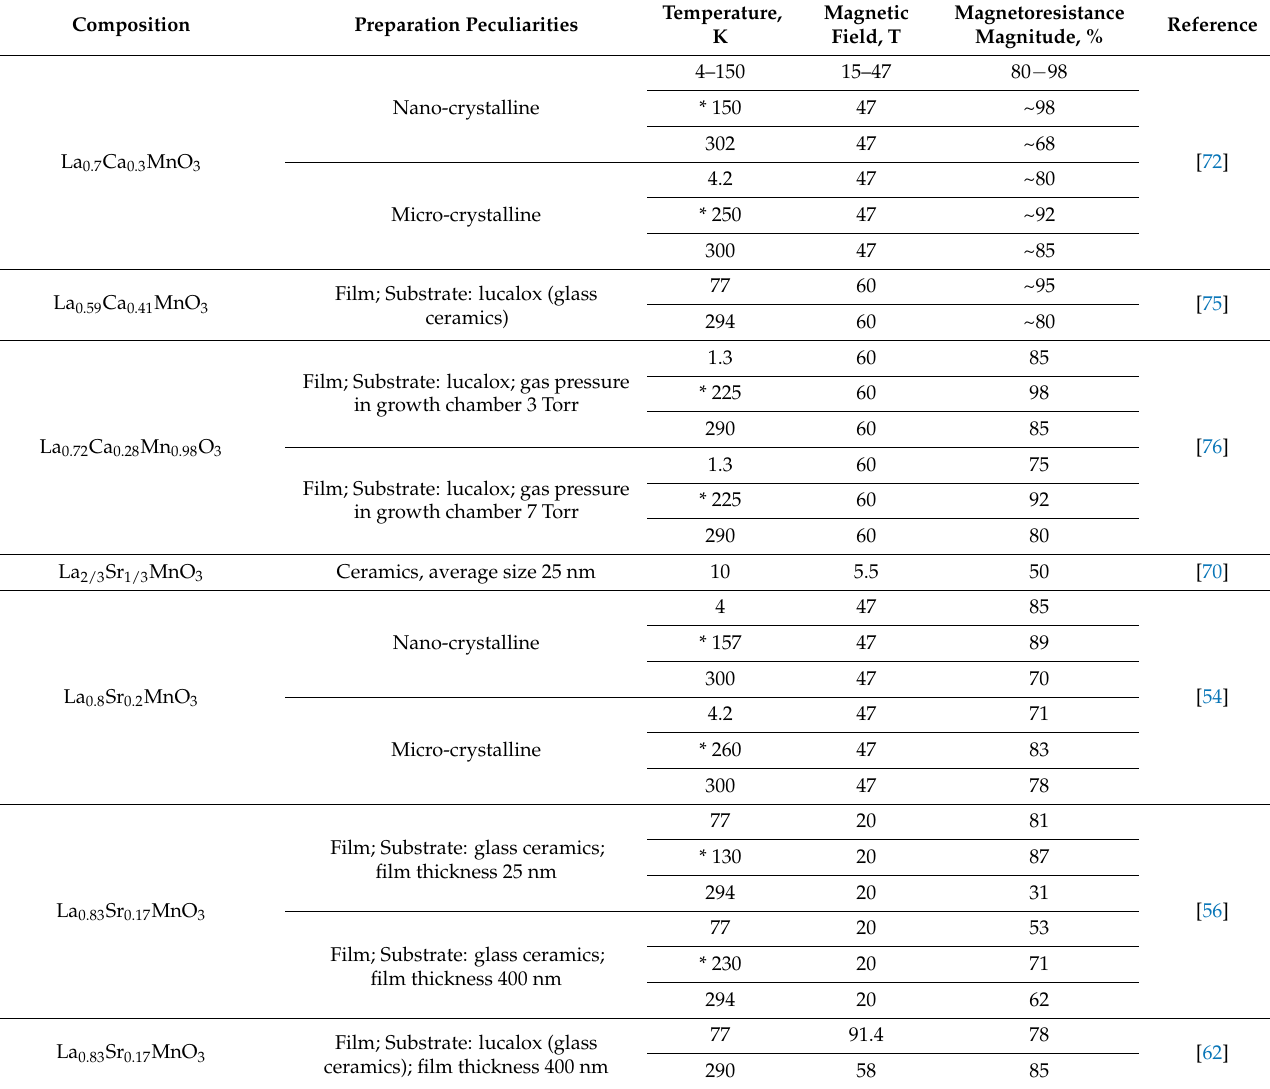
Table 1. Overview of high magnetoresistance magnitudes in polycrystalline manganites measured at low and close to room temperatures in high magnetic fields. The MR at intermediate temperature corresponding to the highest MR value is marked by